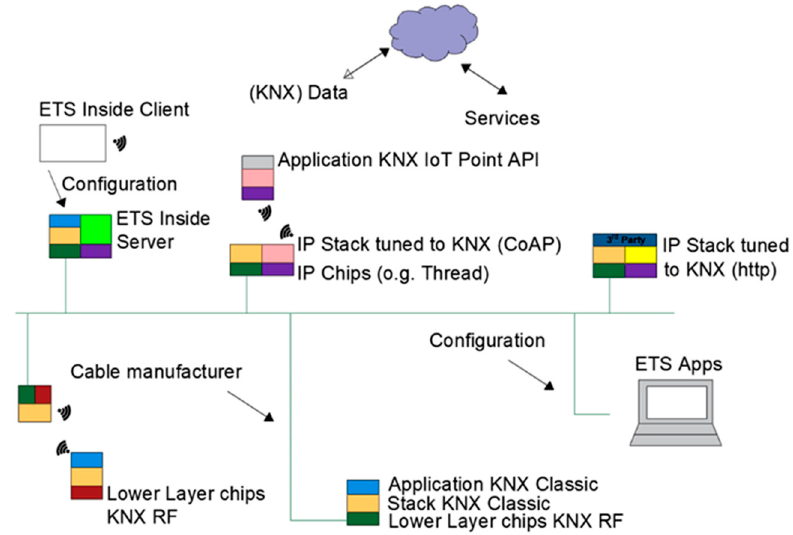
Figure 11. KNX-IoT system.